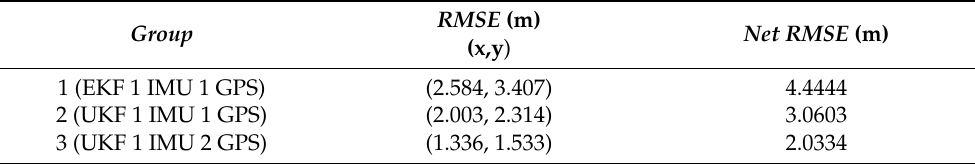
Table 3. Localization errors of each approach during the plotting.